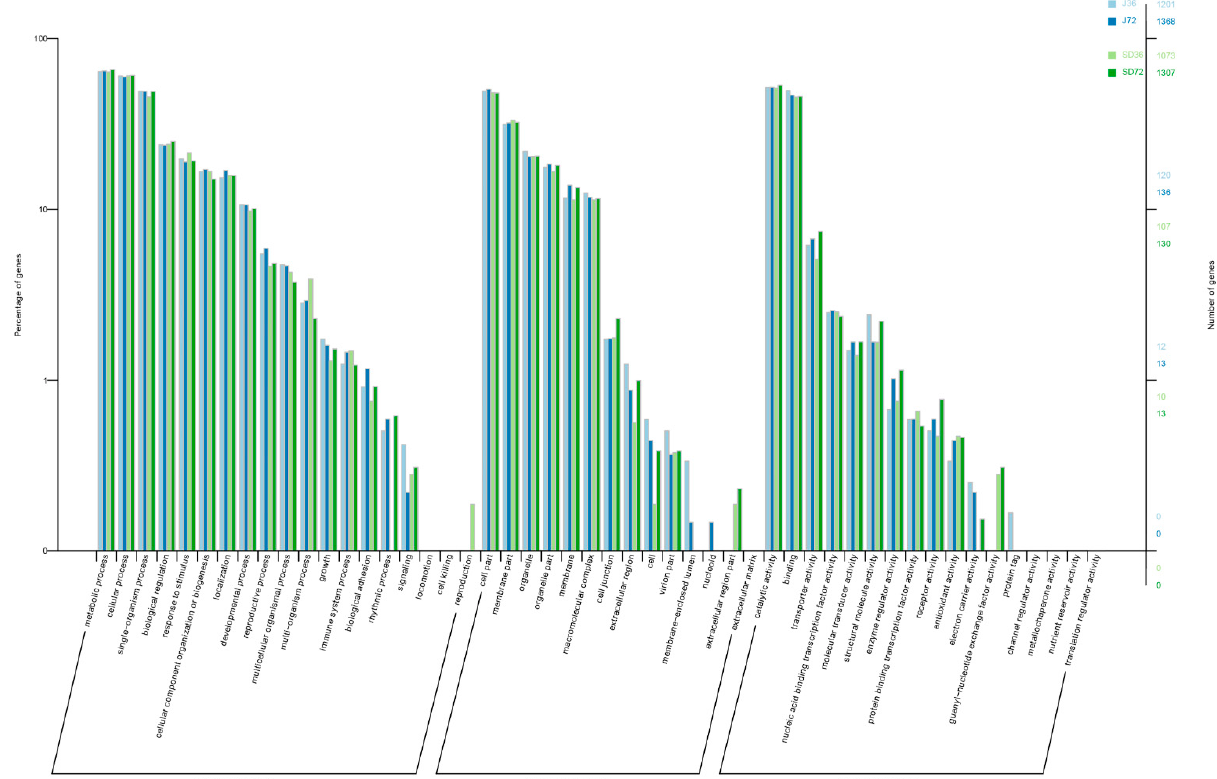
Figure 5. Distribution of GO terms among DSGs in response to A. alternata AP infection in apples. The left y-axis represents the percentage of the DSGs enriched to the GO terms. The right Y-axis represents the numbers of the DSGs enriched to the GO terms. Color scale represents J36, J72, SD36 and SD72 groups, respectively.